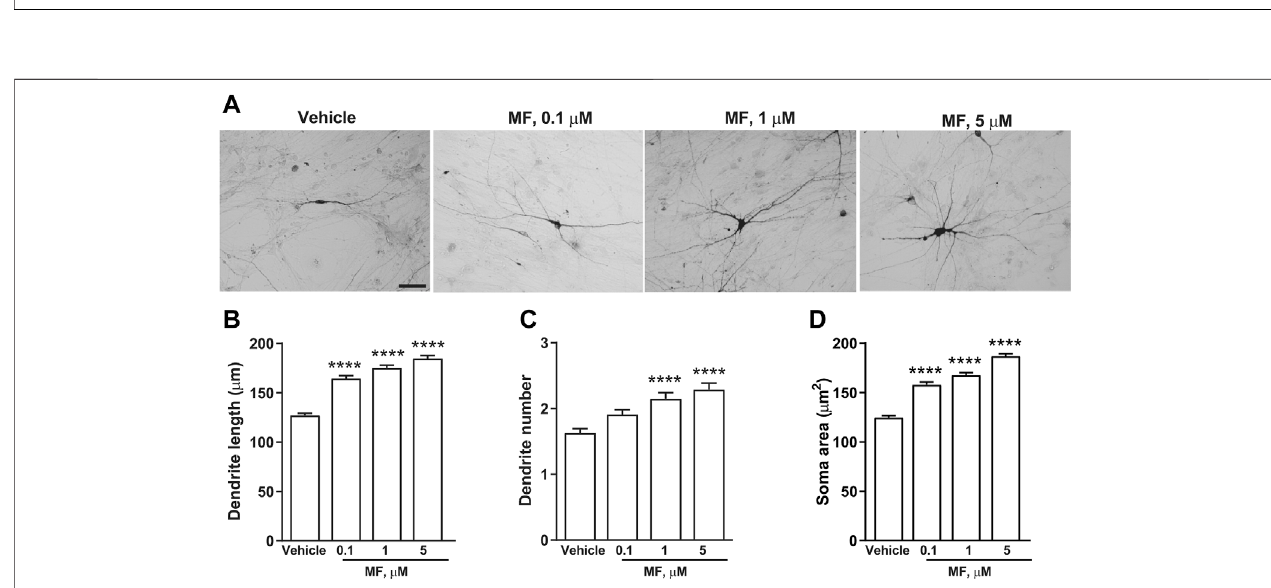
FIGURE6| MFpromotesstructuralplasticityofhumaniPSC-derivedDAneurons.RepresentativephotomicrographsofhumanF3DAneurons(40 daysinculture) 72 h after exposure to vehicle, or MF (0.1, 1, 5 μ m) are shown in (A) . Scale bar: 50 μ m. Treatment effect on maximal dendrite length, number of primary dendrites and soma area of human F3 DA neurons are shown in (B – D) . Values are means ± S.E.M. (**** p < 0.0001; *** p < 0.001; ** p < 0.01 vs. vehicle; One-way ANOVA + Fisher ’ s LSD) (B) F (3,396) = 33.99; p < 0.0001 (C) F (3,396) = 12.61; p < 0.0001 (D) F (3,396) = 9.332; p < 0.0001.